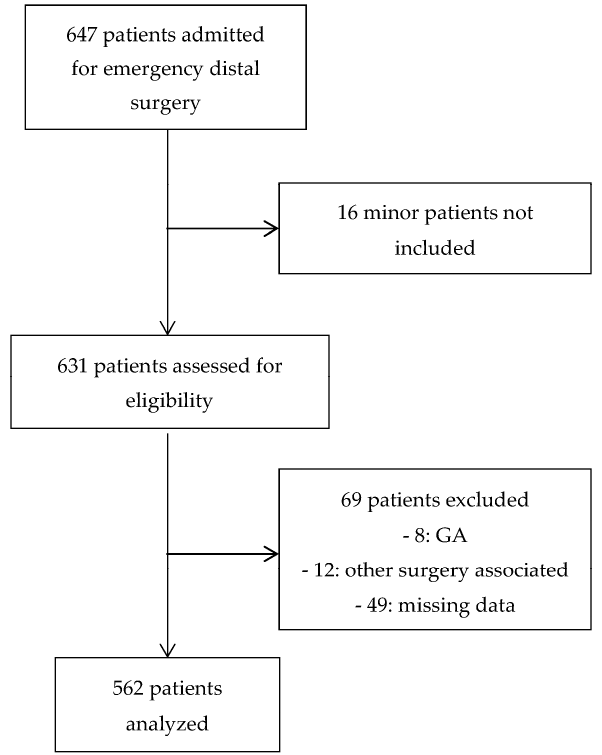
Figure 1. Flow chart of the study population.